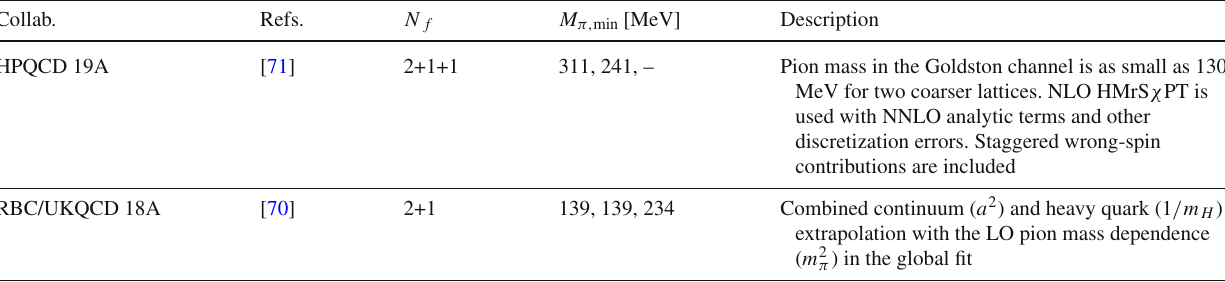
Table 151 Chiral extrapolation/minimum pion mass in determinations of the neutral B -meson mixing matrix elements. For actions with multiple species of pions, masses quoted are the RMS pion masses (where available). The different M π, min entries correspond to the different lattice spacings Collab.